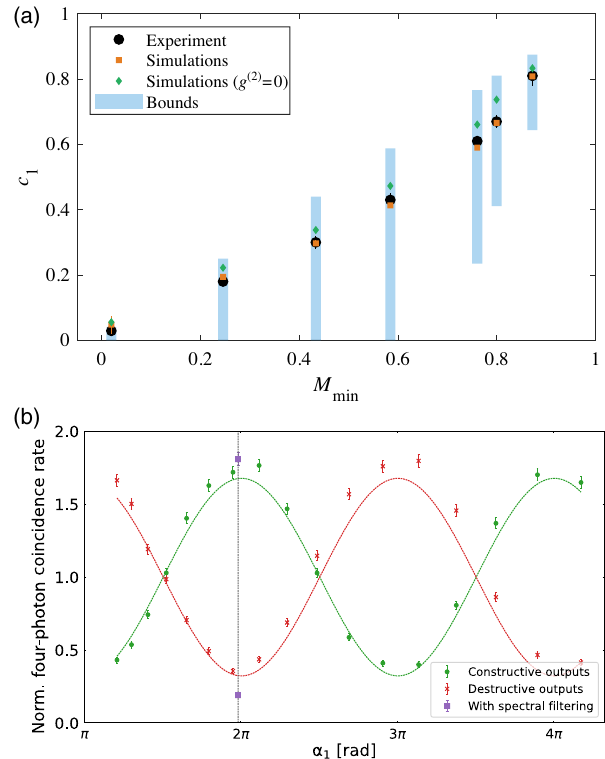
FIG. 5. (a) Four-photon indistinguishability c 1 as a function of the minimum pairwise indistinguishability M . Black circles: min experimental data, extracted from the visibility of the four-photon interference fringe. Orange squares: simulated interference visi- bility including all experimental imperfections. Green diamonds: simulated interference visibility only accounting for partial dis- tinguishability of the input photons, and assuming zero multi- photon emission ( g ð 2 Þ ¼ 0 ), an ideal interferometer, and perfect detection efficiency. Blue shaded regions: upper and lower bounds calculated from Eqs. (9) and (10) using the four measured pairwise indistinguishabilities. (b) Measured four-photon coinci- dence fringe as a function of the internal phase of the interfer- ometer α using a faster DMX to give access to a higher 0 . 800 (cid:2) 0 . 004 . The visibility here is c 0 . 67 (cid:2) 0 . 02 . M 1 ¼ min ¼ The purple points were obtained using a 12 pm Fabry-Perot etalon to spectrally filter the photons and improve the minimum 0 . 8727 (cid:2) 0 . 0007 . Only pairwise indistinguishability to M min ¼ one phase value is sampled here, and we obtain a visibility of c 1 ¼ 0 . 81 (cid:2) 0 . 03 are plotted as orange squares. In all cases, there is a very good agreement between the data and simulations. For